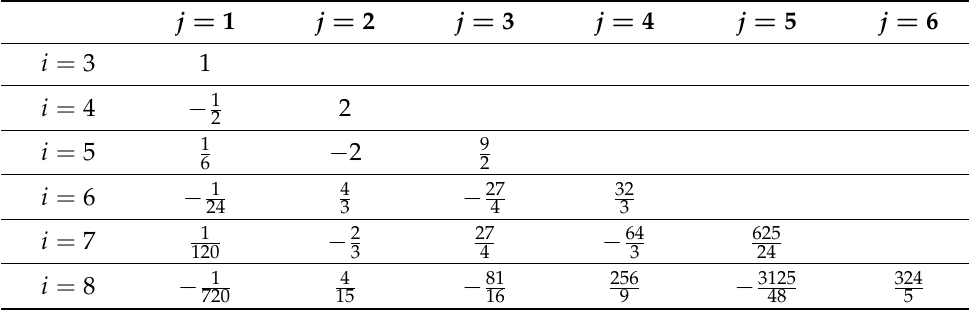
Table 2. Coefficients a i , j , 3 ≤ i ≤